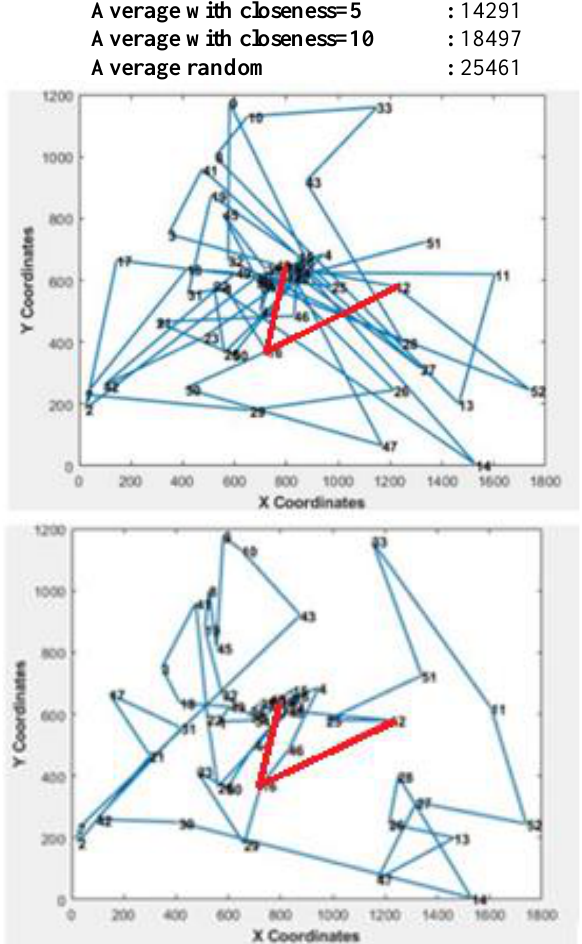
Fig 10. Eil76 path after iteration number 1: With random choice, with closeness parameters at 10